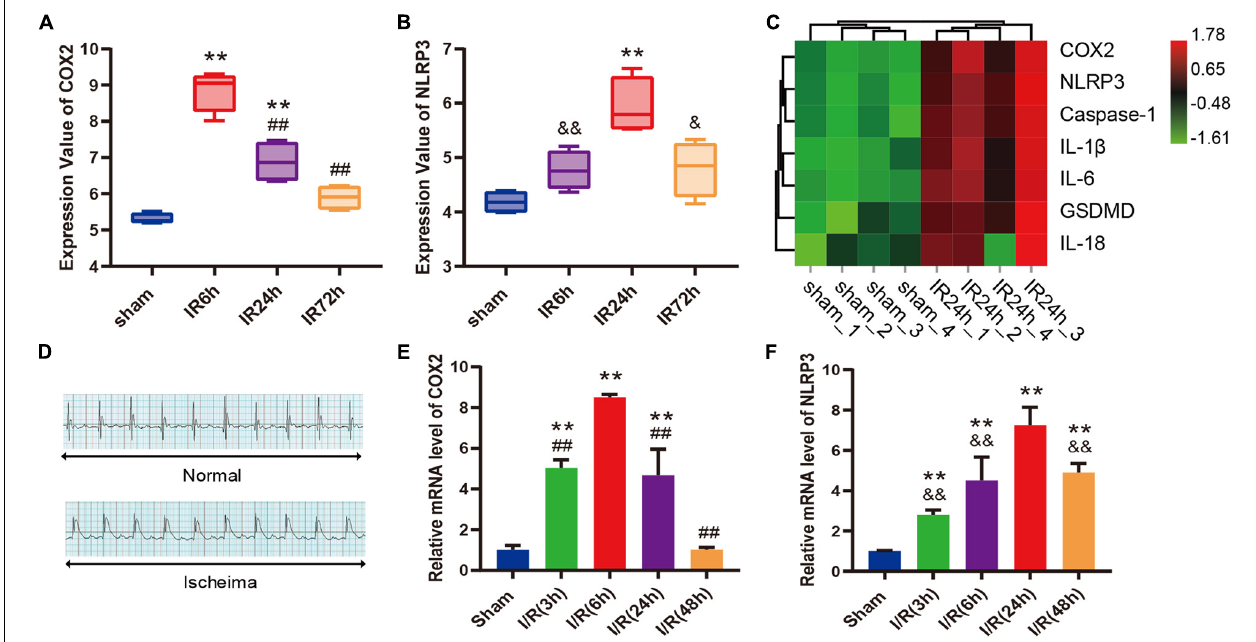
FIGURE 3 | COX2 and molecules associated with pyroptosis were both up-regulated after myocardial I/R. (A,B) Transcriptional expression values of COX2 and NLRP3 in sham samples and I/R samples of GSE160516 dataset. n = 4. (C) Expression heatmap of COX2, NLRP3, caspase-1, IL-1 β , IL-6, GSDMD, and IL-18 in sham samples and IR24h samples. Each column represents a sample and each row represents expression profile of a specific gene. The color scale demonstrates the relative gene expression level in certain grid: green and red indicate the low and high expression values of the gene, respectively. (D) Representative electrocardiograph before and after ligation of LAD in vivo model of myocardial I/R. (E,F) Changes in mRNA expression levels of COX2 and NLRP3 after myocardial reperfusion. n = 5. Data are expressed as the mean ± SD; ** p < 0.01 versus sham group or Sham group; ## p < 0.01 versus IR6h group or I/R(6h) group; & p < 0.05, && p < 0.01 versus IR24h group or I/R(24h) group. I/R, ischemia/reperfusion; LAD, left anterior descending coronary